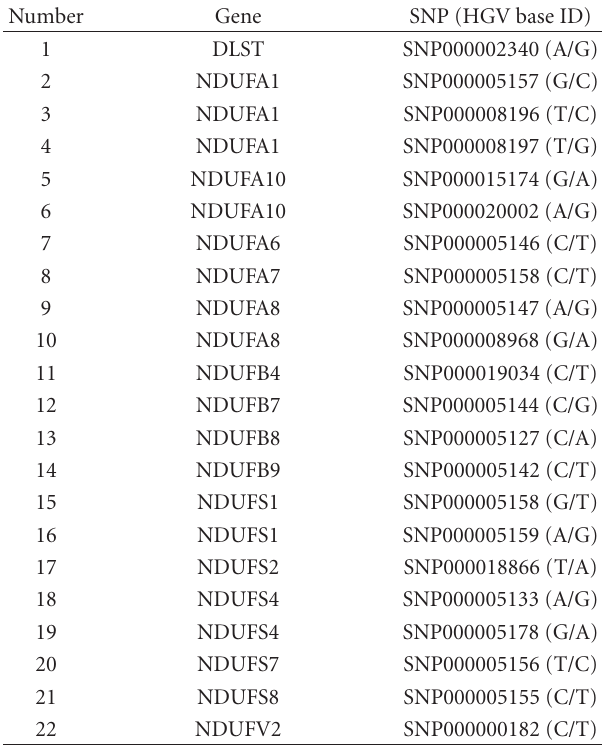
Table 1: The genes and SNPs